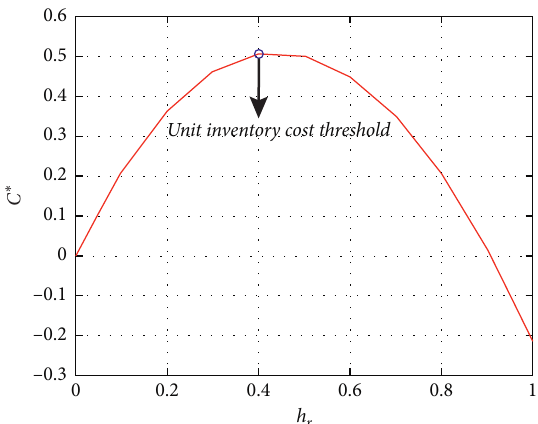
Figure 22: Effect of unit inventory cost h